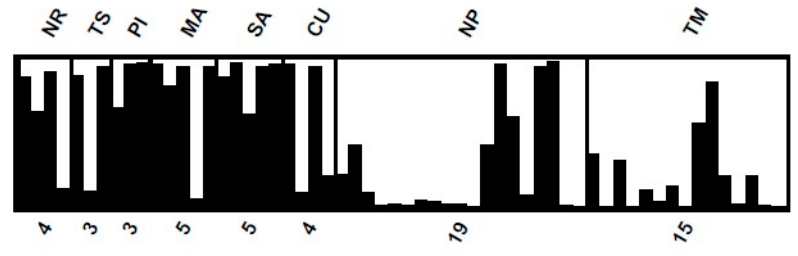
Figure 2. Population structure for the 58 G. crinita samples from eight provenances at two K value. The provenance codes are given above, and the numbers of samples per provenance are given